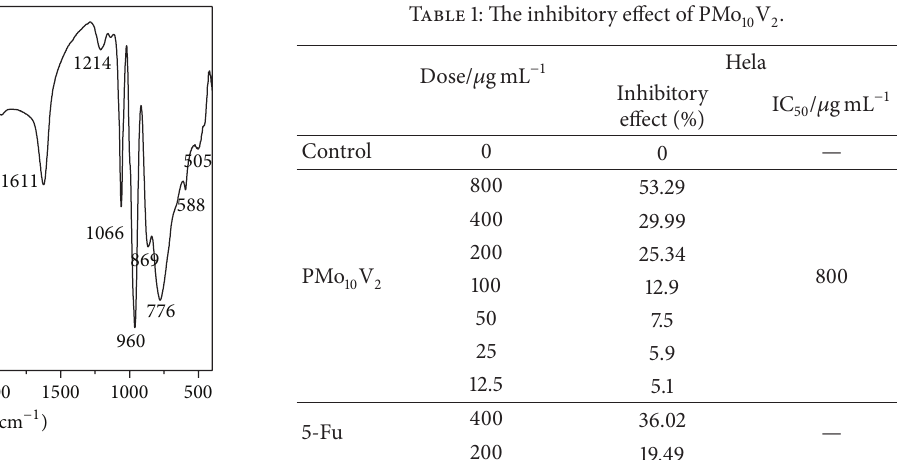
Figure 1: IR spectrum of the PMo 10 V 2 .